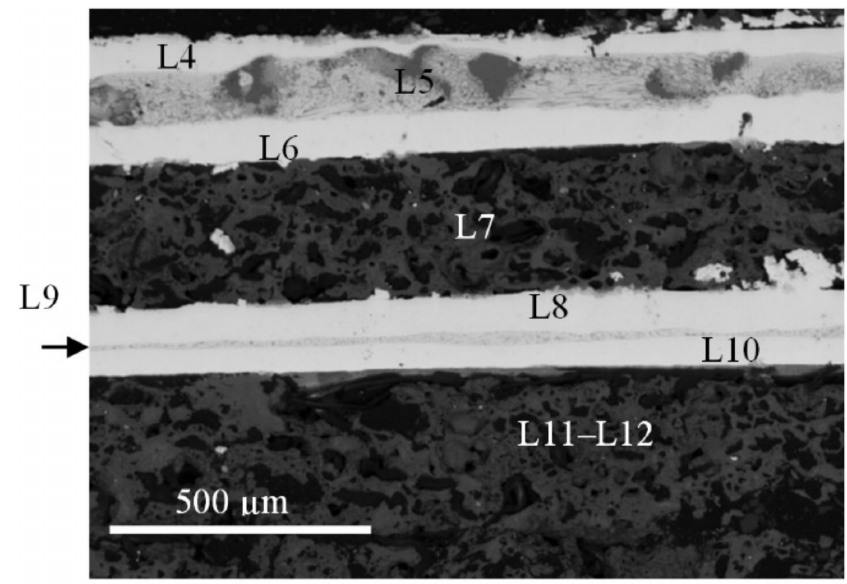
Figure 12. Cross section fragment of a composite derived from Set 3 (Table